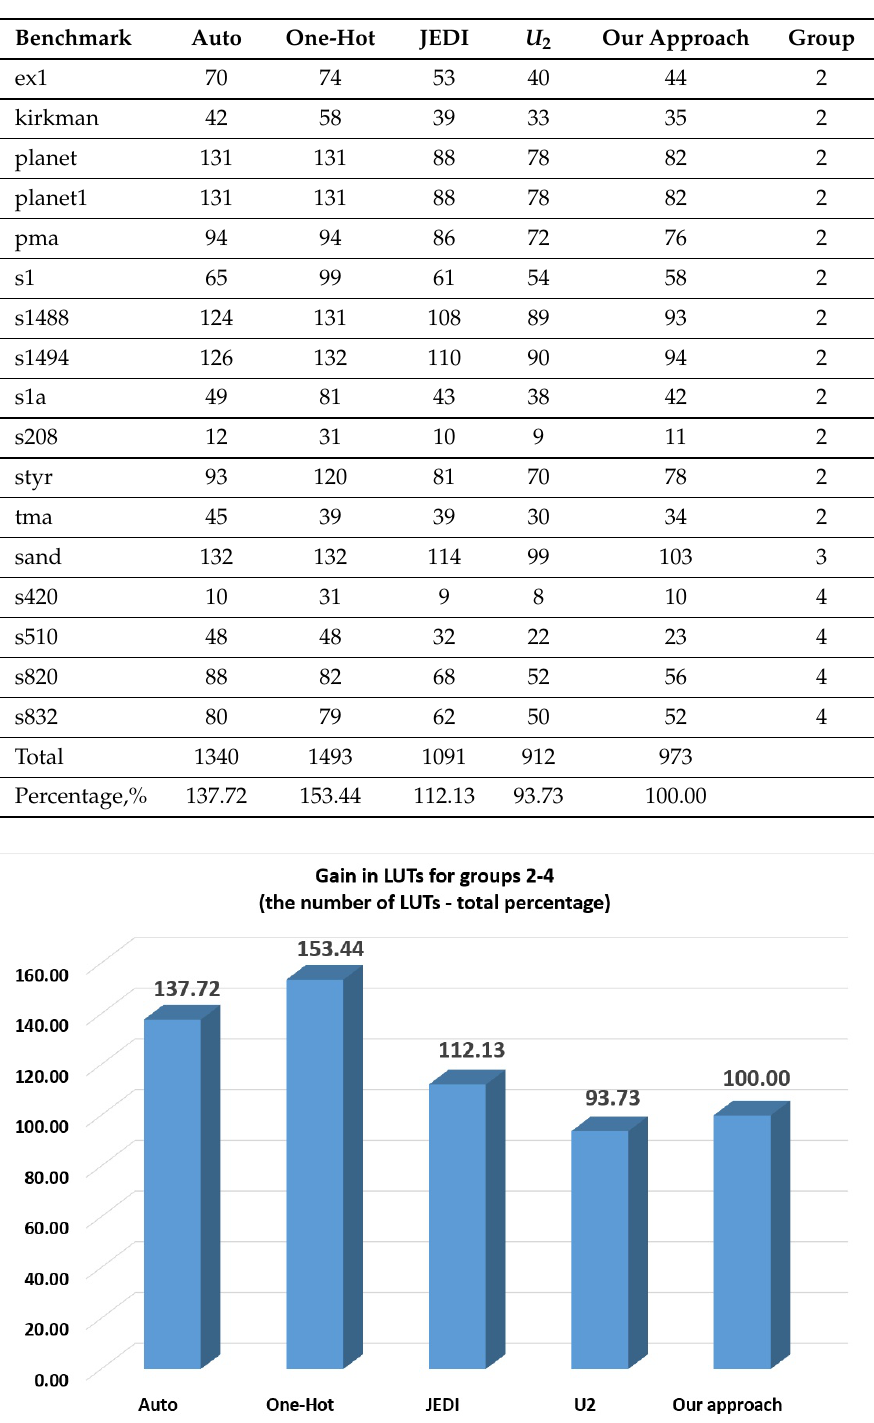
Table 11. Gain in LUTs for groups 2–4 (LUT count).